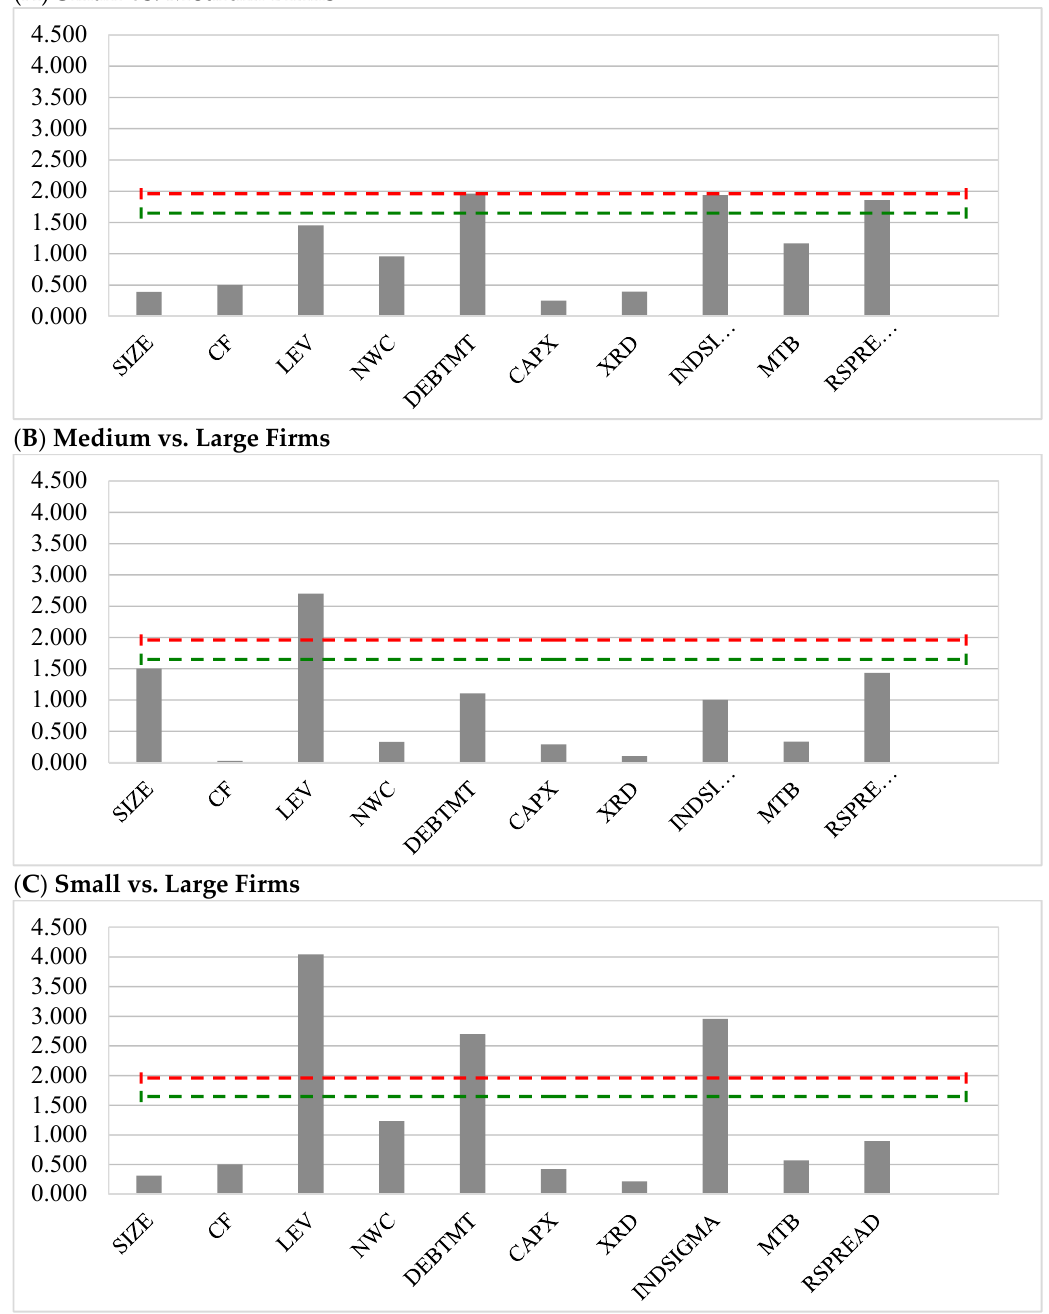
Figure 4. Differences between cash holdings’ determinants in size subgroupings for UK firms. Note: Figure 4. Di ff erences between cash holdings’ determinants in size subgroupings for UK firms.